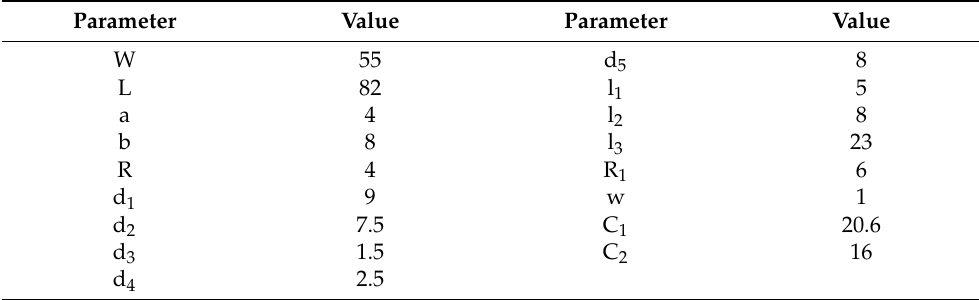
Table 3. Final optimization results of the parameters of Vivaldi narrow-beam antenna